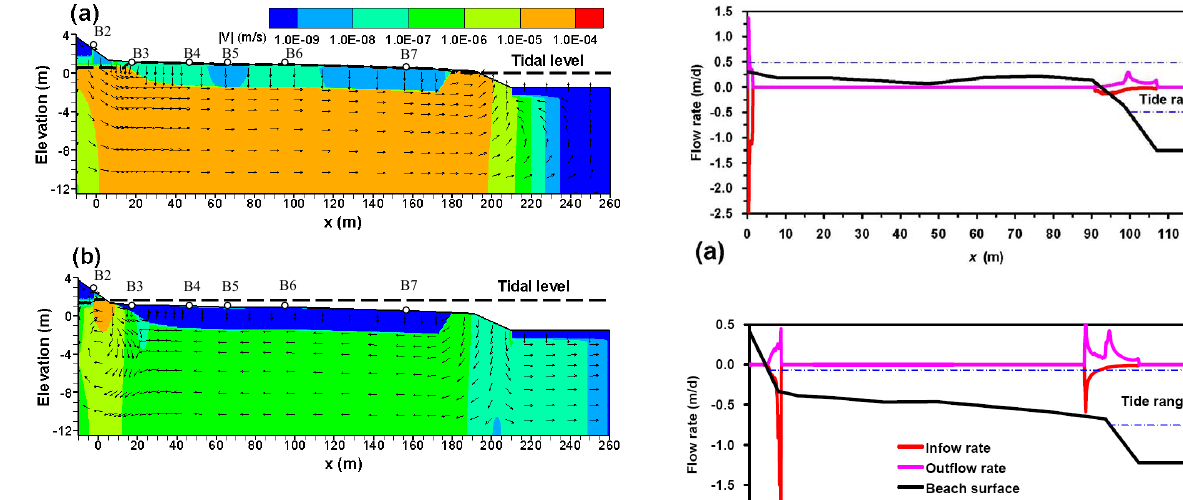
Fig. 11. Darcy velocities (banded colorful contours) in the bald beach transect (a) at low tide (Time=35.5 h) and (b) at high tide (Time=41.0 h). Vectors with uniform length were used to indicate the velocity direction only. The long dashed line denotes water table.